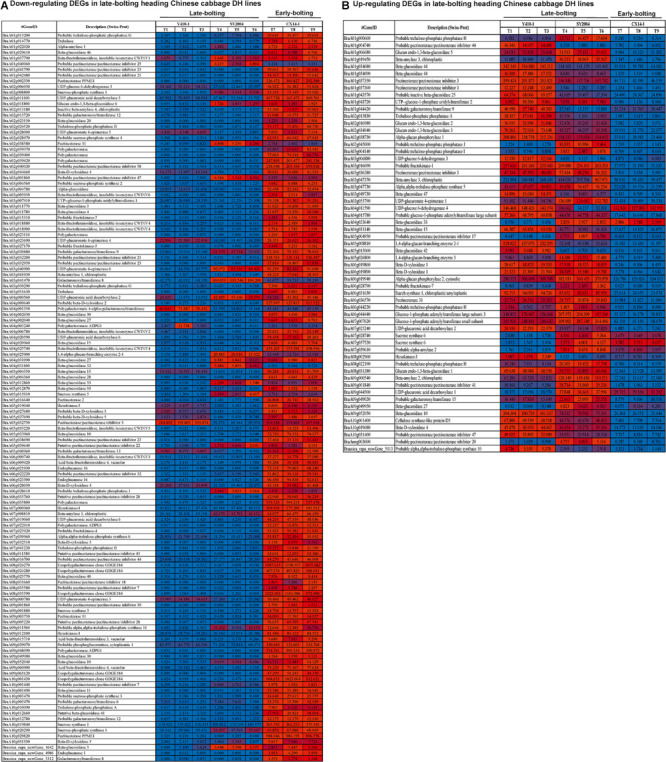
Heatmap representation of the expression pattern [fragments per kilobase of transcript per million fragments mapped (FPKM) values] of differentially expressed genes (DEGs) related to starch and sucrose metabolism. (A) Downregulated and (B) upregulated DEGs in both late-bolting heading Chinese cabbage double haploid (DH) lines.